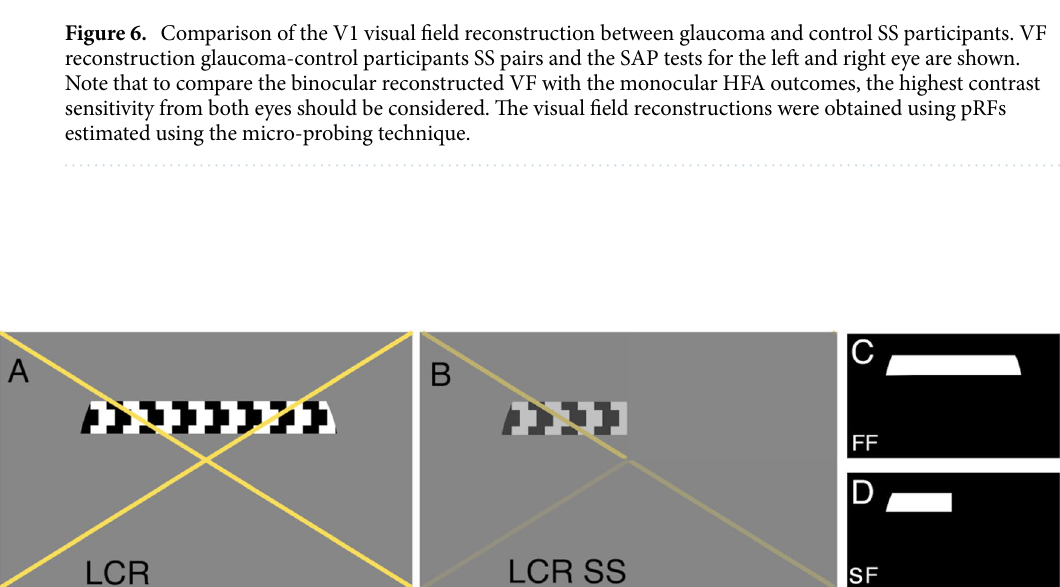
Figure 7. Example of the stimuli used to obtain pRF parameter estimates. ( A ) LCR stimulus. (B) LCR SS stimulus, this particular example depicts the contrast sensitivity loss of participant G01 (MD(OS) = − 14.72 MD (OD) = − 8.37). The colour of the cross changed between yellow and black, and served to guide the gaze of the participant with central scotomas to the center of the cross. ( C , D ) Show the full field (FF) the scotoma field (SF) models used in the pRF analysis,